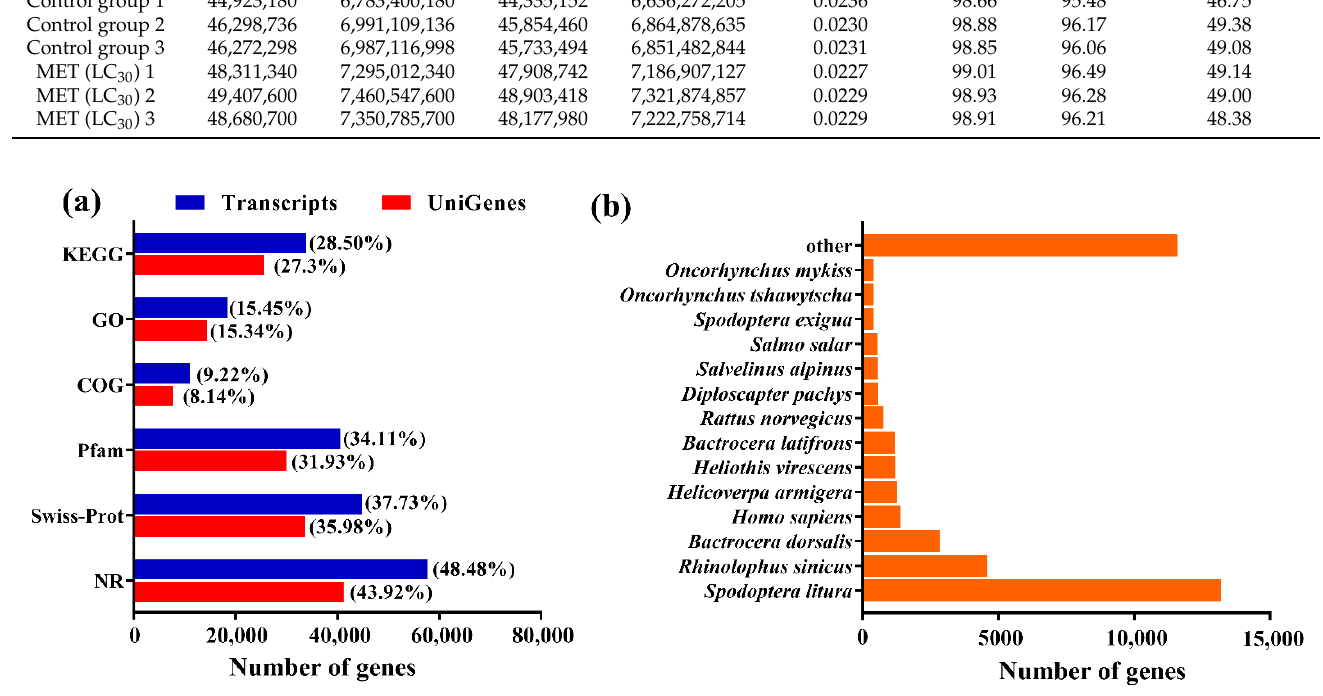
Figure 1. Gene annotation and homology search. ( a ) The number of genes using six databases. NR, Swiss-Prot, Pfam, COG, GO, and KEGG. ( b ) Homology search of Illumina sequences matching with the NR database. 18,935 NR-annotated transcripts sequences were analyzed for species distribution.